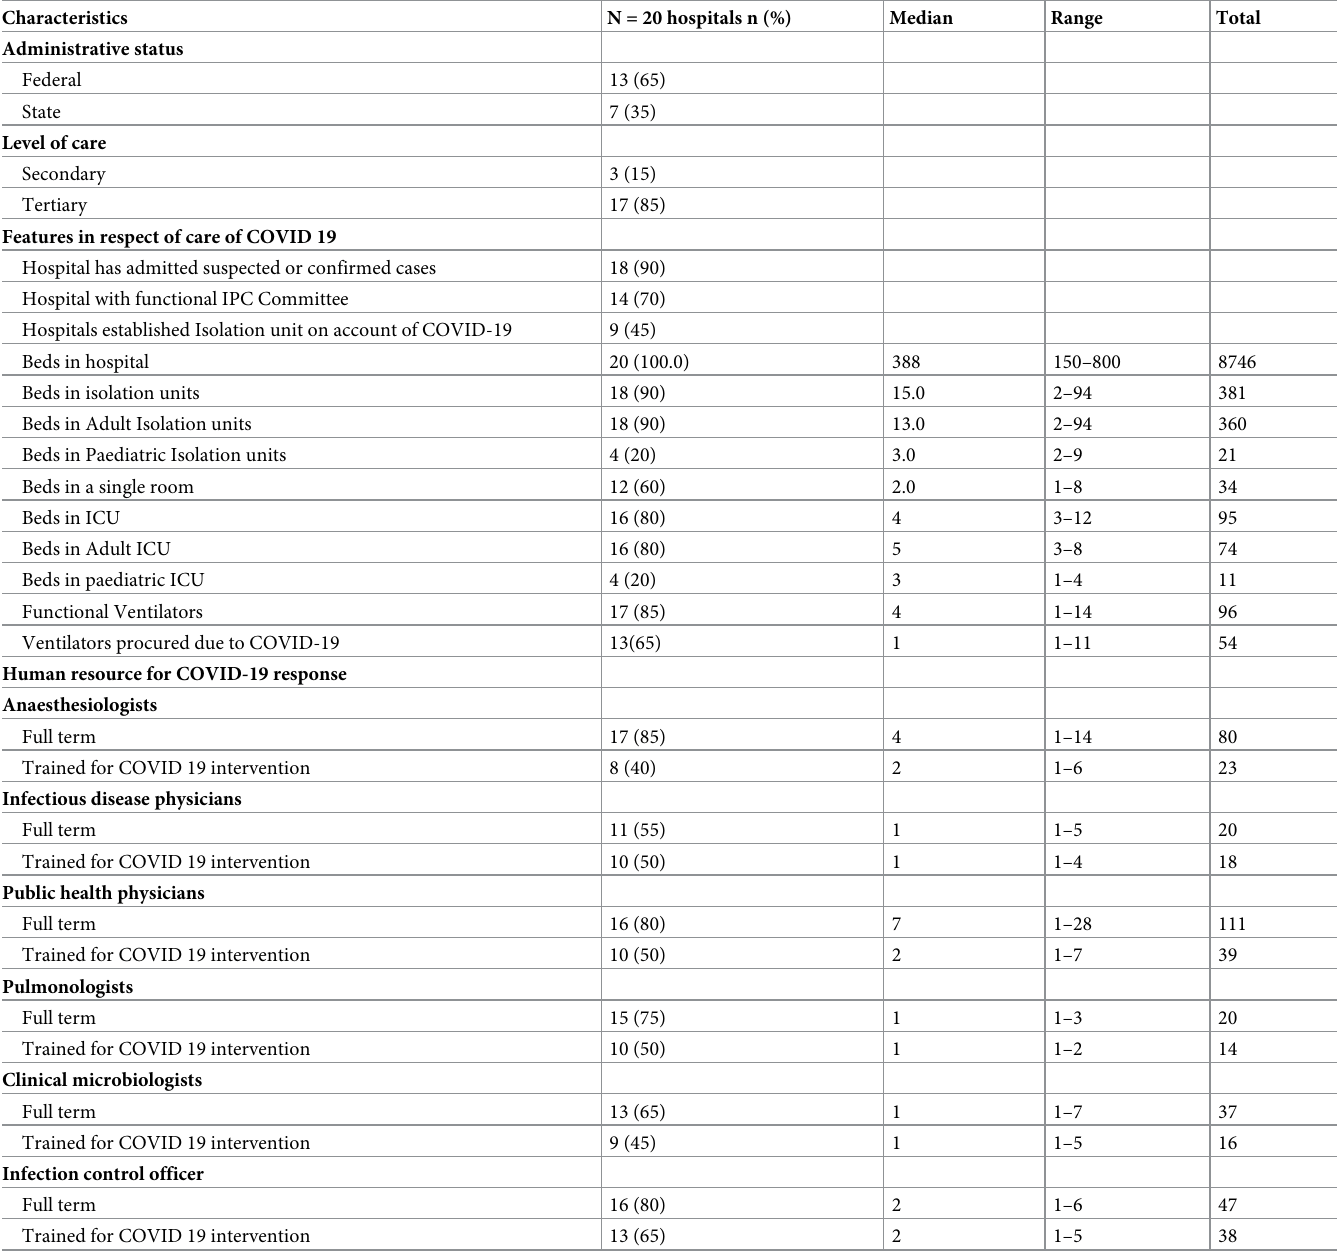
Table 1. COVID-19 hospital readiness in Nigeria: Characteristics of hospital surveyed.